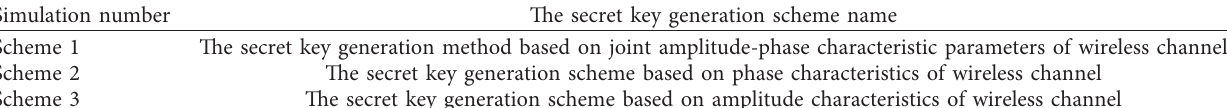
Table 2: The secret key generation scheme corresponding to simulation number.